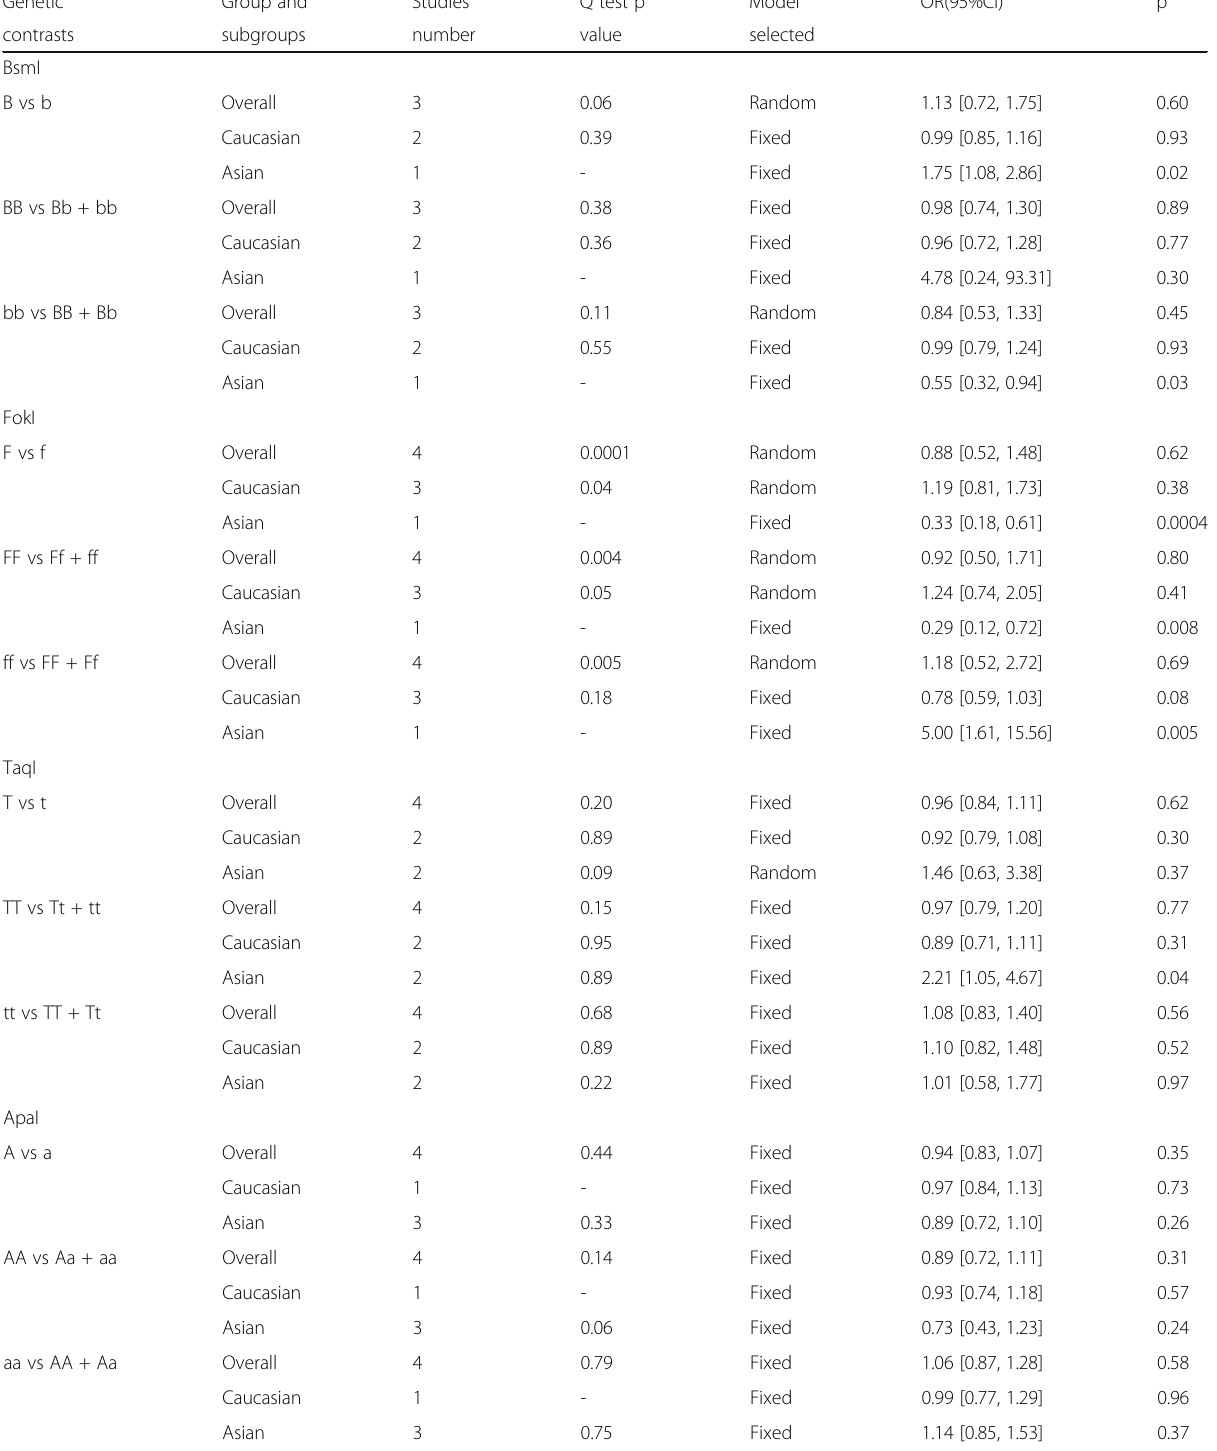
Table 2 Meta analysis of the association of VDR BsmI,FokI, TaqI and ApaI gene polymorphisms with DN risk